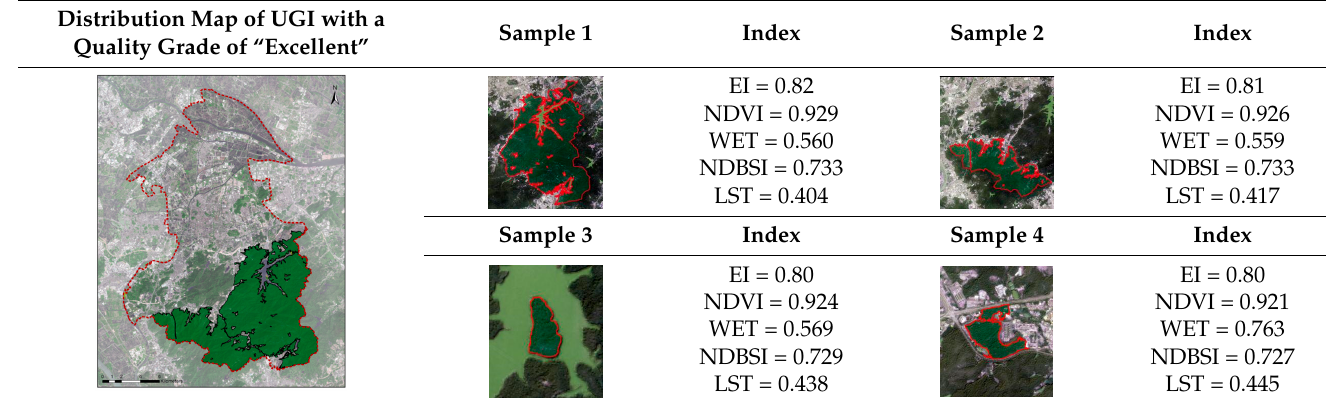
Table 8. UGI area and proportion of each greening quality grade.